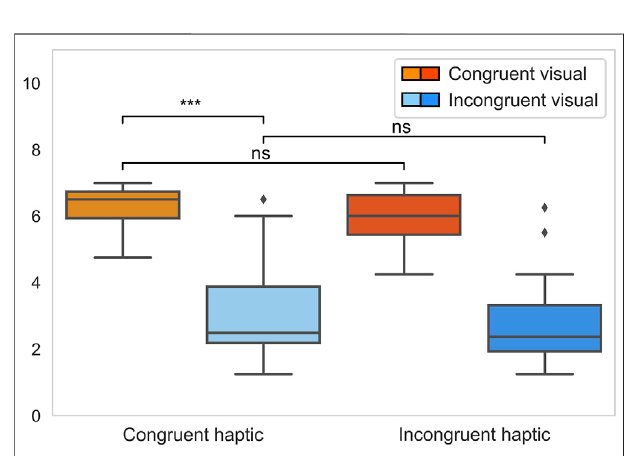
FIGURE 7 | Agency scores across conditions, computed for each participant using the mean of answers to the corresponding questions in the last four blocks of the